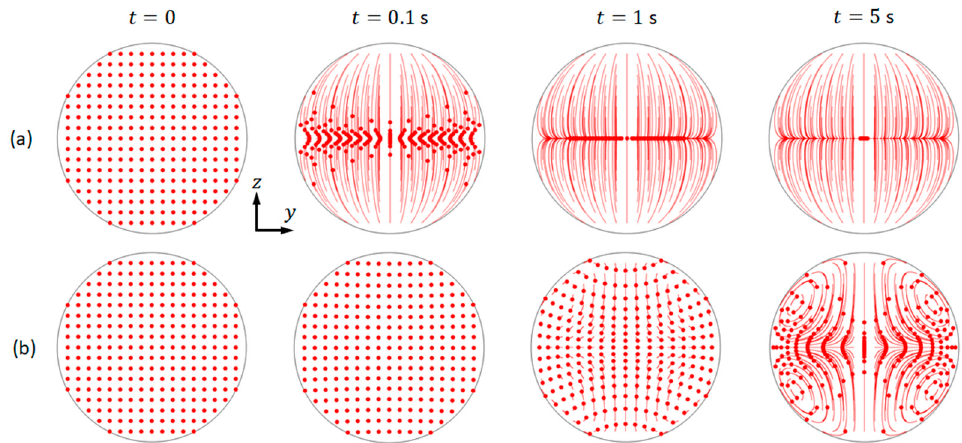
Figure 5. The modelled trajectories of microparticles under the combination of acoustic radiation and streaming-induced drag forces. Particles with diameters of ( a ) 10 µ m; and, ( b ) 1 µ m, where the red dots and the associated lines represent the microparticles and their trajectories, respectively.